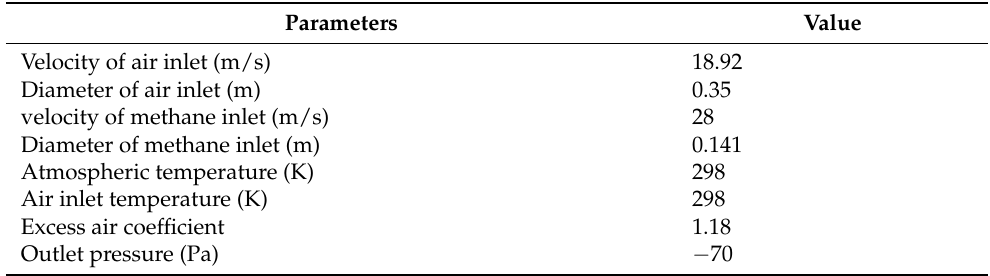
Table 3. Parameters for the experiments.